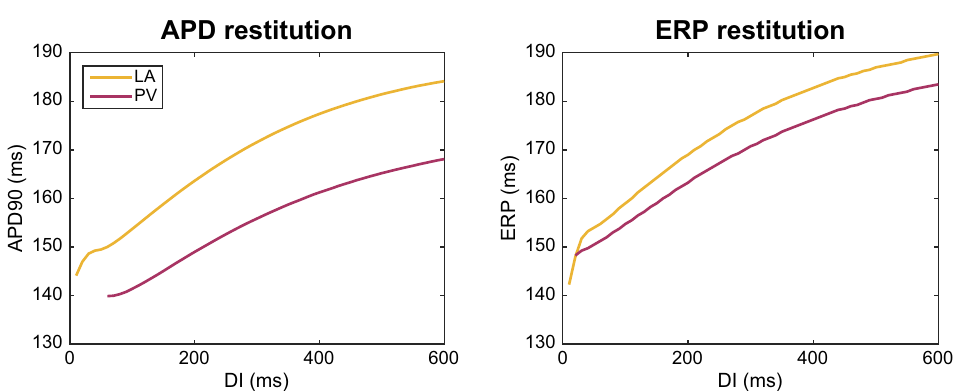
Figure 4. Action potential duration (APD) and effective refractory period (ERP) restitution curves for the LA and PV base models. For the APD restitution curve, the APD90 value is computed for a number of different diastolic interval (DI) values. The diastolic interval is defined as the time between the time point when the membrane potential has returned to 90% repolarization in the previous action potential (resulting from an S1 stimulation) to the time the next stimulation (S2) is applied. To compute the ERP restitution, a third stimulation (S3) is applied for each S2 DI. This S3 stimulation (lasting for 3 ms and of an amplitude about twice as large as was needed to generate an action potential from rest) is applied at progressively shorter time intervals after the S2 stimulation and the ERP is defined as the longest S2S3 interval that failed to capture 60